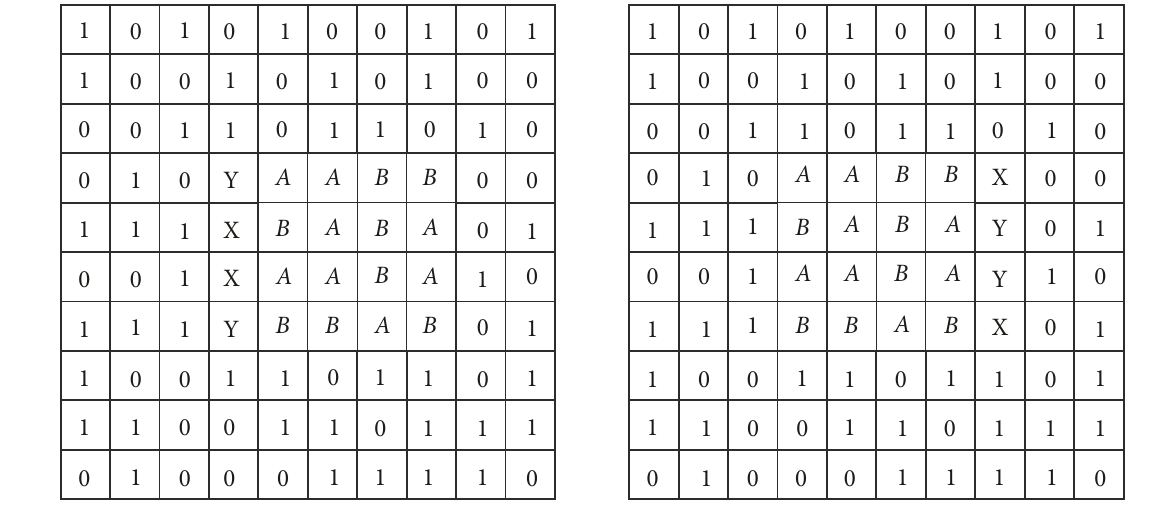
Figure 11: Diagram to show the relationship between the left and right images in Figure 10. Reproduced from [91, Figure 2.4-3], with permission of Alcatel-Lucent/Bell